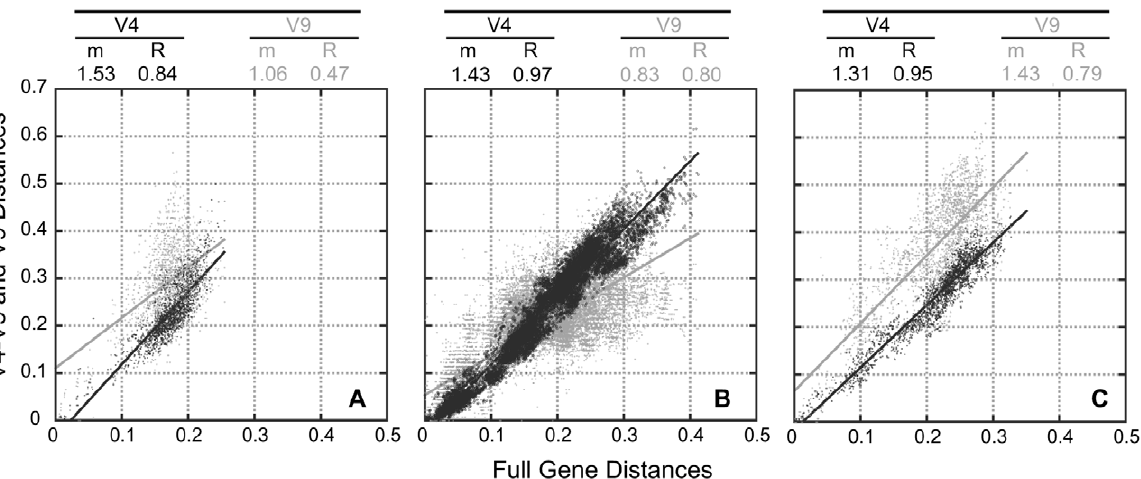
Figure 1. Comparison of partial and full-length 18S rDNA sequences to infer genetic distances. The three panels show pair-wise genetic distances (Jukes Cantor corrected) of the complete gene against partial regions (V4–V5 in dark grey or V9 in light grey) for sequences within Stramenopiles (A), Alveolata (B), and Rhizaria (C). Slopes (m) and coefficients (R) of the correlations are shown at the top of the graphs.